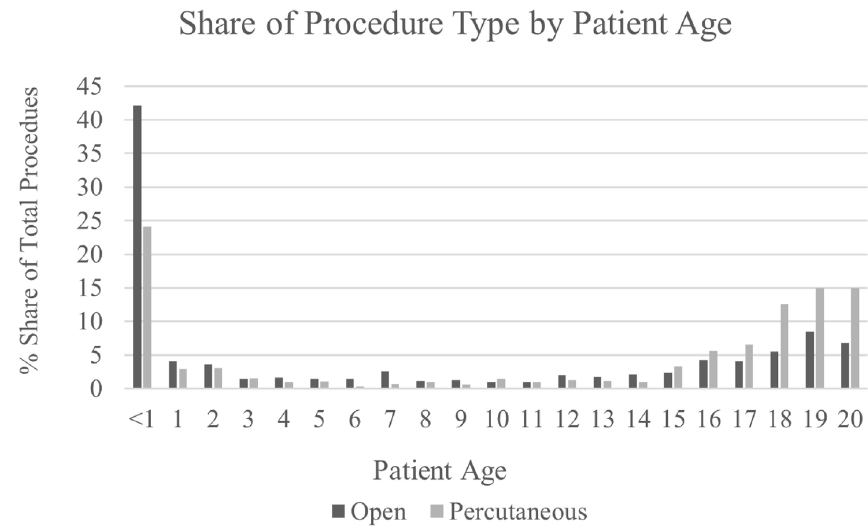
Fig. 1 Percentage share of procedure type by patient age, OT, and PT